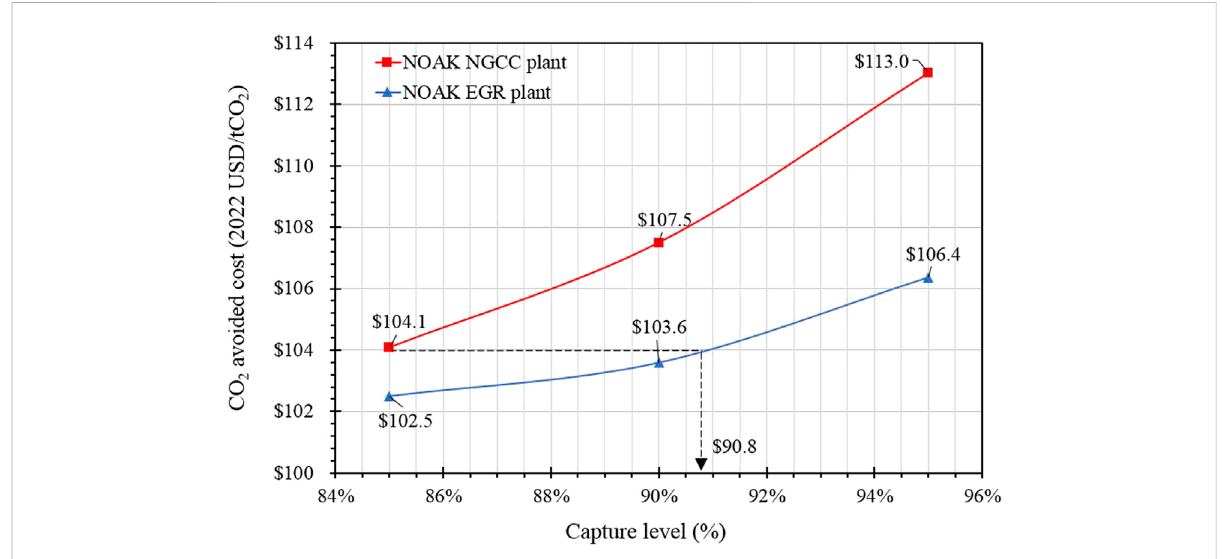
FIGURE 8 Carbon mitigation cost estimation for future NGCC and EGR power plants as a function of the capture level at η 2 nd = 40%.